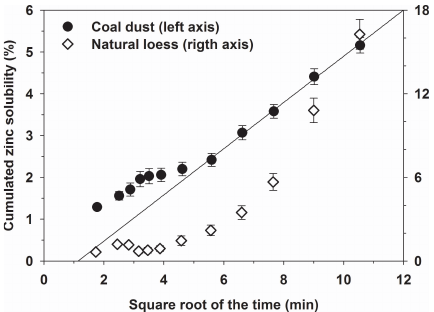
Fig. 7. Cumulated solubility of zinc (%) as function of the